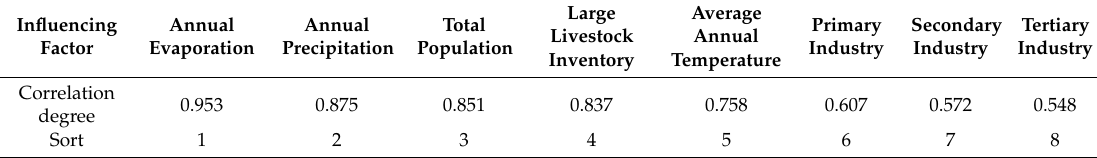
Table 9. Correlation degree and correlation sequence of wetland area, with influencing